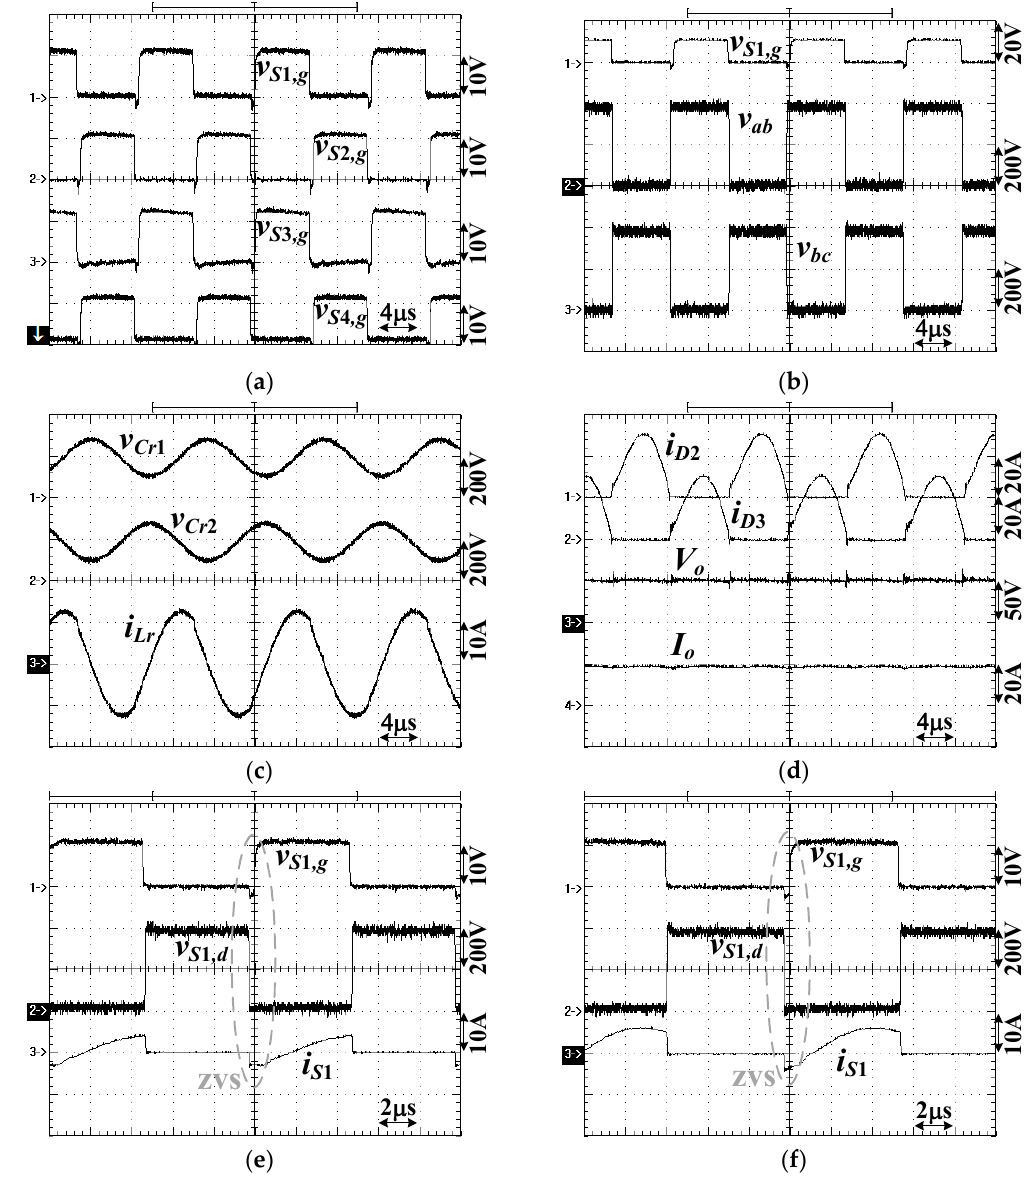
Figure 8. Experiments of the presented converter under V o = 50 V: ( a ) v S 1 ,g , v S 2 ,g , v S 3 ,g , and v S 4 ,g under V in = 760 V and P o = 1 kW; ( b ) v S 1 ,g , v ab , and v bc under V in = 760 V and P o = 1 kW; ( c ) v Cr 1 , v Cr 2 , and i Lr under V in = 760 V and P o = 1 kW; ( d ) i D 2 , i D 3 , V o , and I o under V in = 760 V and P o = 1 kW; ( e ) v S 1 ,g , v S 1 ,d , and i S 1 under V in = 760 V and P o = 200 W; and ( f ) v S 1 ,g , v S 1 ,d , and i S 1 under V in = 760 V and P o = 1